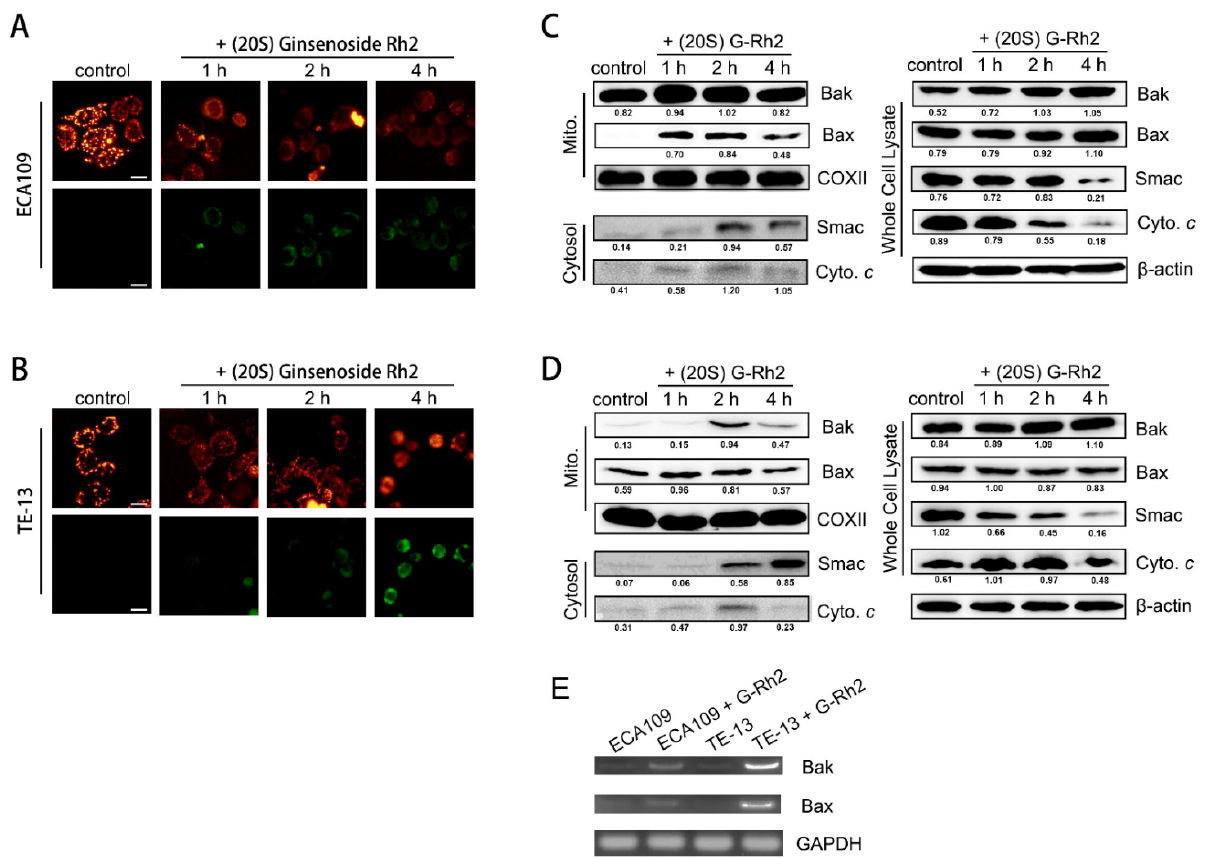
Figure 4. (20S) ginsenoside Rh2-induced intrinsic apoptosis in human esophageal cells. ( A , B ) (20S) G-Rh2 induces both mitochondrial membrane depolarization in ECA109 and TE-13 cells. Cells were treated with 7.5 µ g/mL (20S) G-Rh2 for 1, 2, and 4 h and strained with the mitochondrial membrane potential assay kit with JC-1. Images were captured by using a fluorescence microscope at the excitation wavelengths of 570 and 500 nm; ( C , D ) apoptosis regulated proteins in cytosolic and mitochondrial fractions as well as in the total cell lysates that were analyzed by Western blotting; ( E ) RT-PCR results of Bax and Bak upon treatment with (20S) G-Rh2. Both Bax and Bak were upregulated in mRNA levels in ECA109 and TE-13 cells.